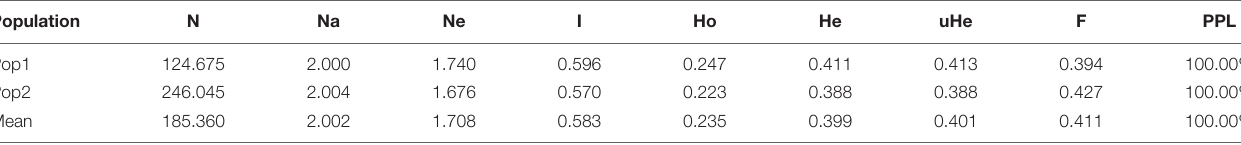
TABLE 4 | Mean of different genetic parameters in each of the two subpopulations. Population N Na Ne I Ho He uHe F